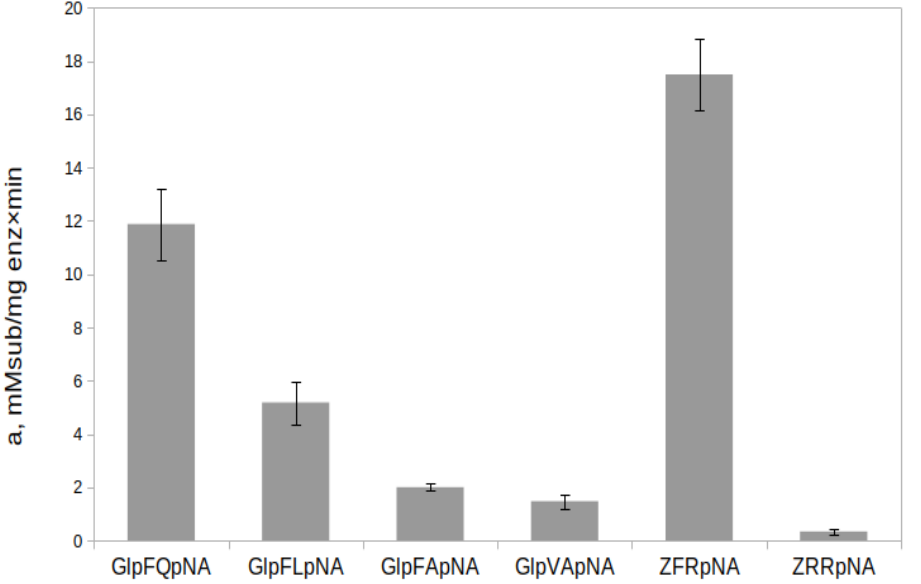
Figure 8. Substrate specificity of rTcCathL1 measured for a range of dipeptide substrates. Activity was measured in 0.1 M UB, pH 5.6 in the presence of 6 mM cysteine and 1 mM EDTA.